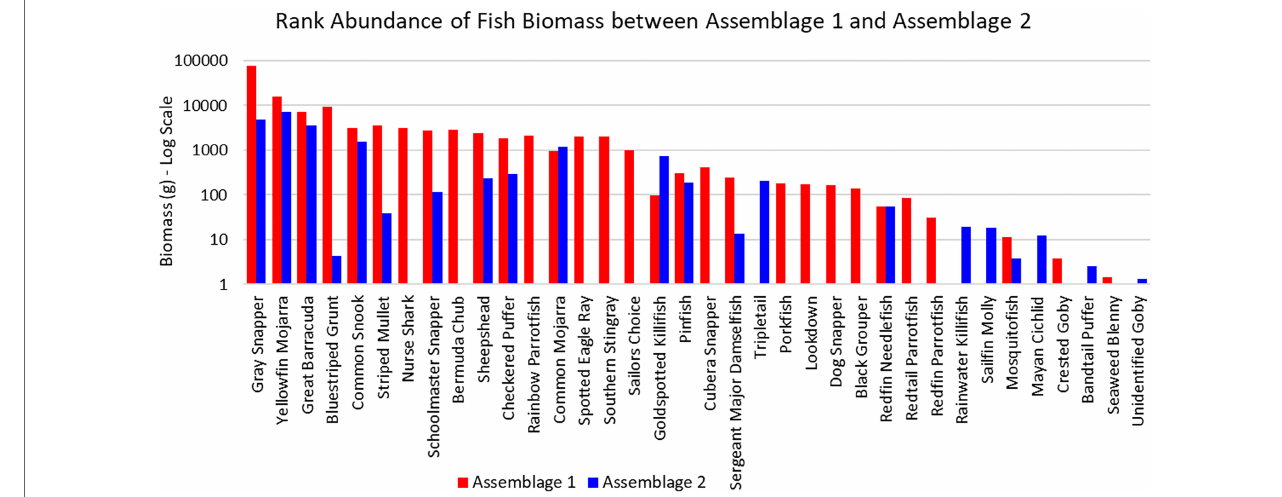
FIGURE 6 | Ranked biomass of fish species found in Assemblages 1 and 2. The biomasses are averaged by the number of sites forming each assemblage and shown on a log scale.